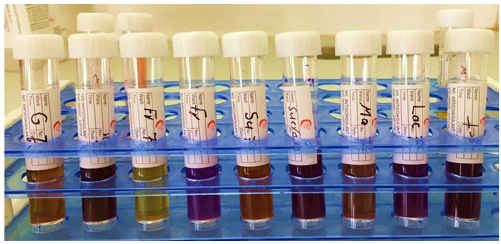
Fig. 3. Sugar fermentation test for Urease +ve bacteria isolated table 4. Sugar fermentation for the bacterial